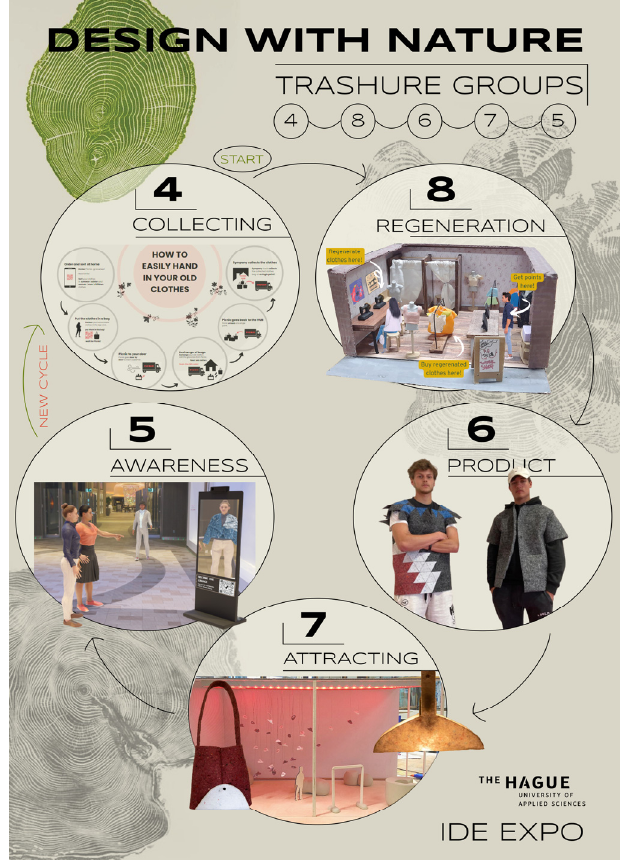
Figure 12. All Trashure DwN Expo poster Circular Textiles, Expo- M. Becker. 4.3. RQ 3: What Pedagogical or Didactical Factors in Biomimicry Methodology Did Students Struggle with or Find